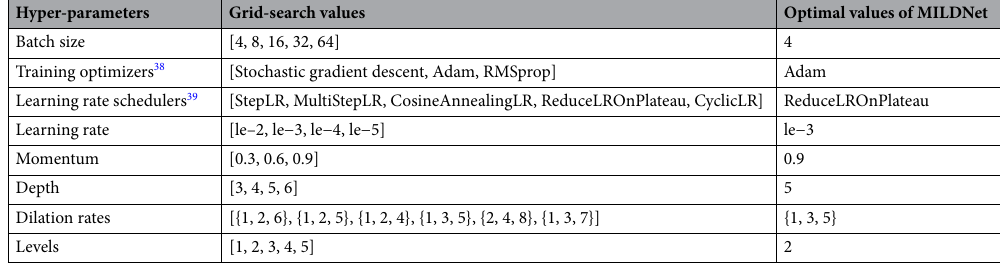
Table 3. Combination of the hyper-parameter settings and their optimal values found using grid-search in a 5-fold CV. In this study, we used the optimal hyper-parameter values of the MILDNet to train the baseline approaches. The same folds are also used during training, validation, and testing of the proposed and the baseline